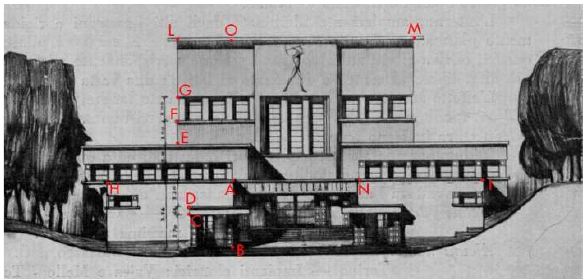
Table 2. Comparison of distance and residuals